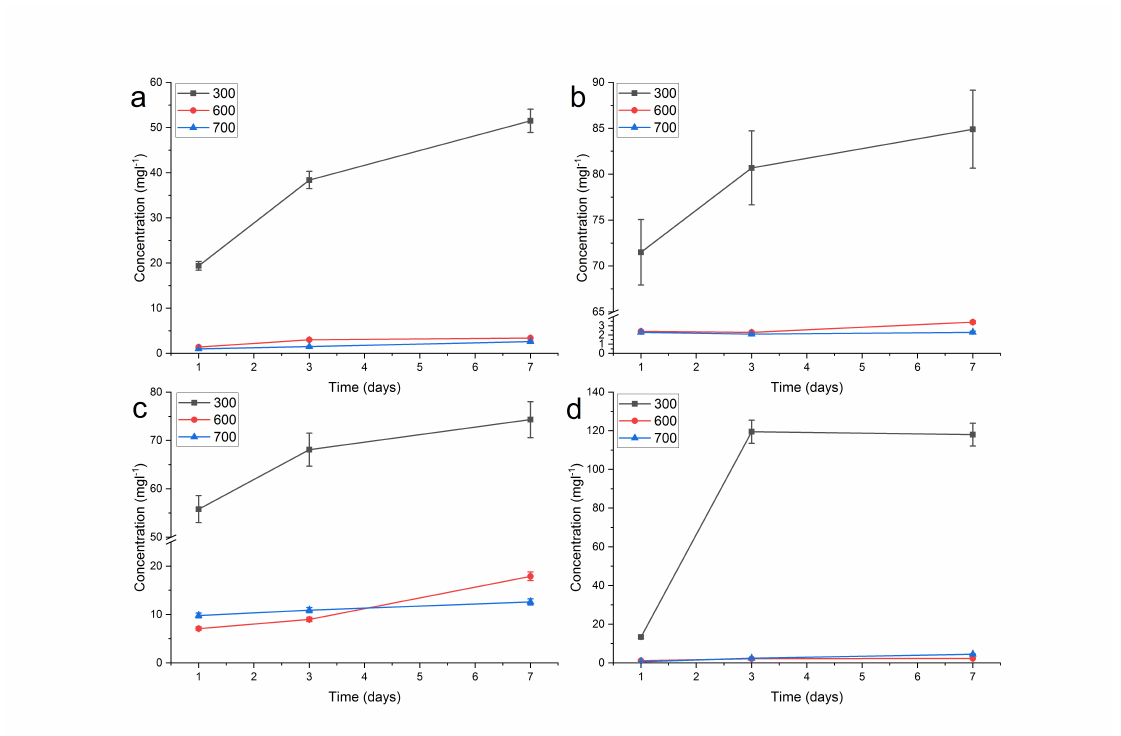
Figure A4. Comparison of Ag release at ( a ) 40 ◦ C; ( b ) 60 ◦ C; ( c ) pH 4; and ( d ) pH 10 for SiO 2 -Ag 300, SiO 2 -Ag 600, and SiO 2 -Ag 700, marked as 300, 600 and 700 in the graphs, respectively. The time scale is in days. Table A1. Silver release (mg · L − 1 ) from SiO 2 -Ag 300, SiO 2 -Ag 600 and SiO 2 -Ag 700 for 1, 3 and 7 days at room temperature (RT) in de-ionized water (DI), at 40 ◦ C and 60 ◦ C, and pH 4 and pH 10. The errors are estimated as ±